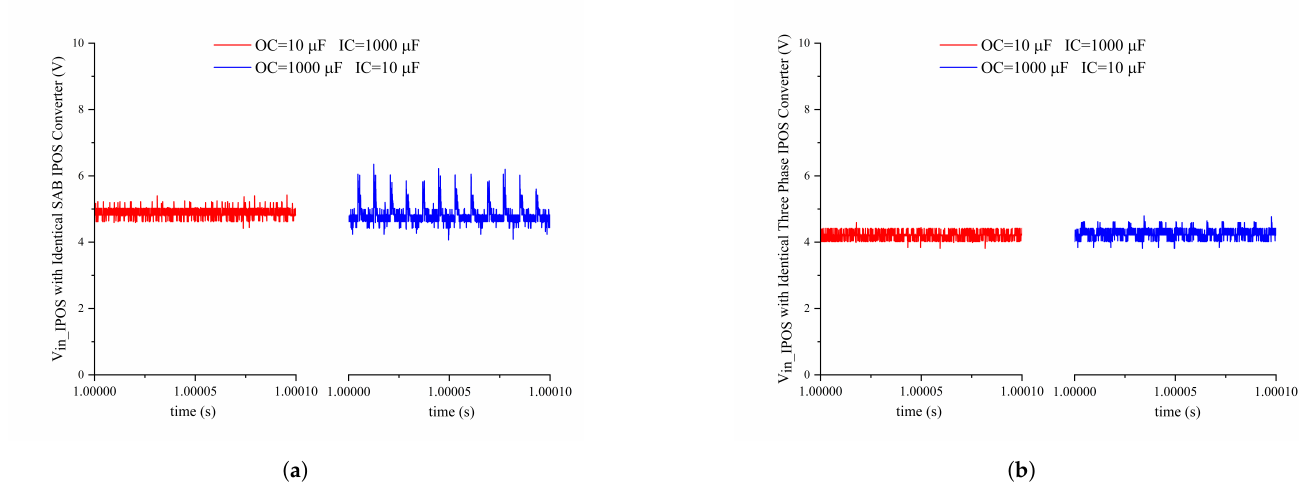
Figure 14. Comparison of the waveform of V in_IPOS under different situations. ( a ) V in_IPOS with Identical SAB IPOS Converter; and ( b )V in_IPOS with Identical Three Phase IPOS